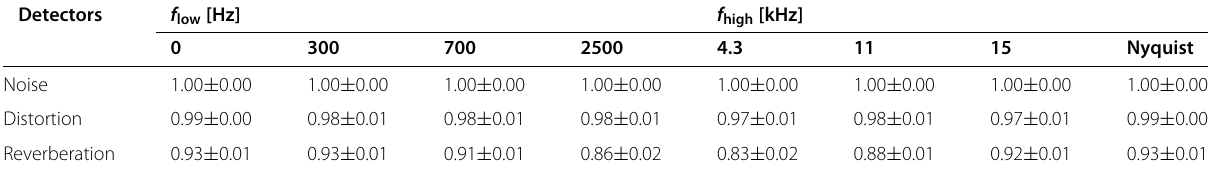
Table 4 The impact of changing the lower and higher cutoff frequencies of the log-mel spectrogram on the performance of each detector for pathological voice